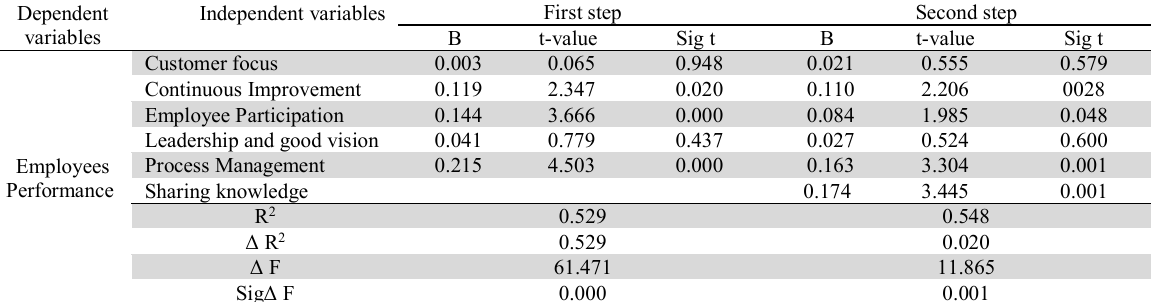
The results of the Hierarchical regression (α≤0.05)